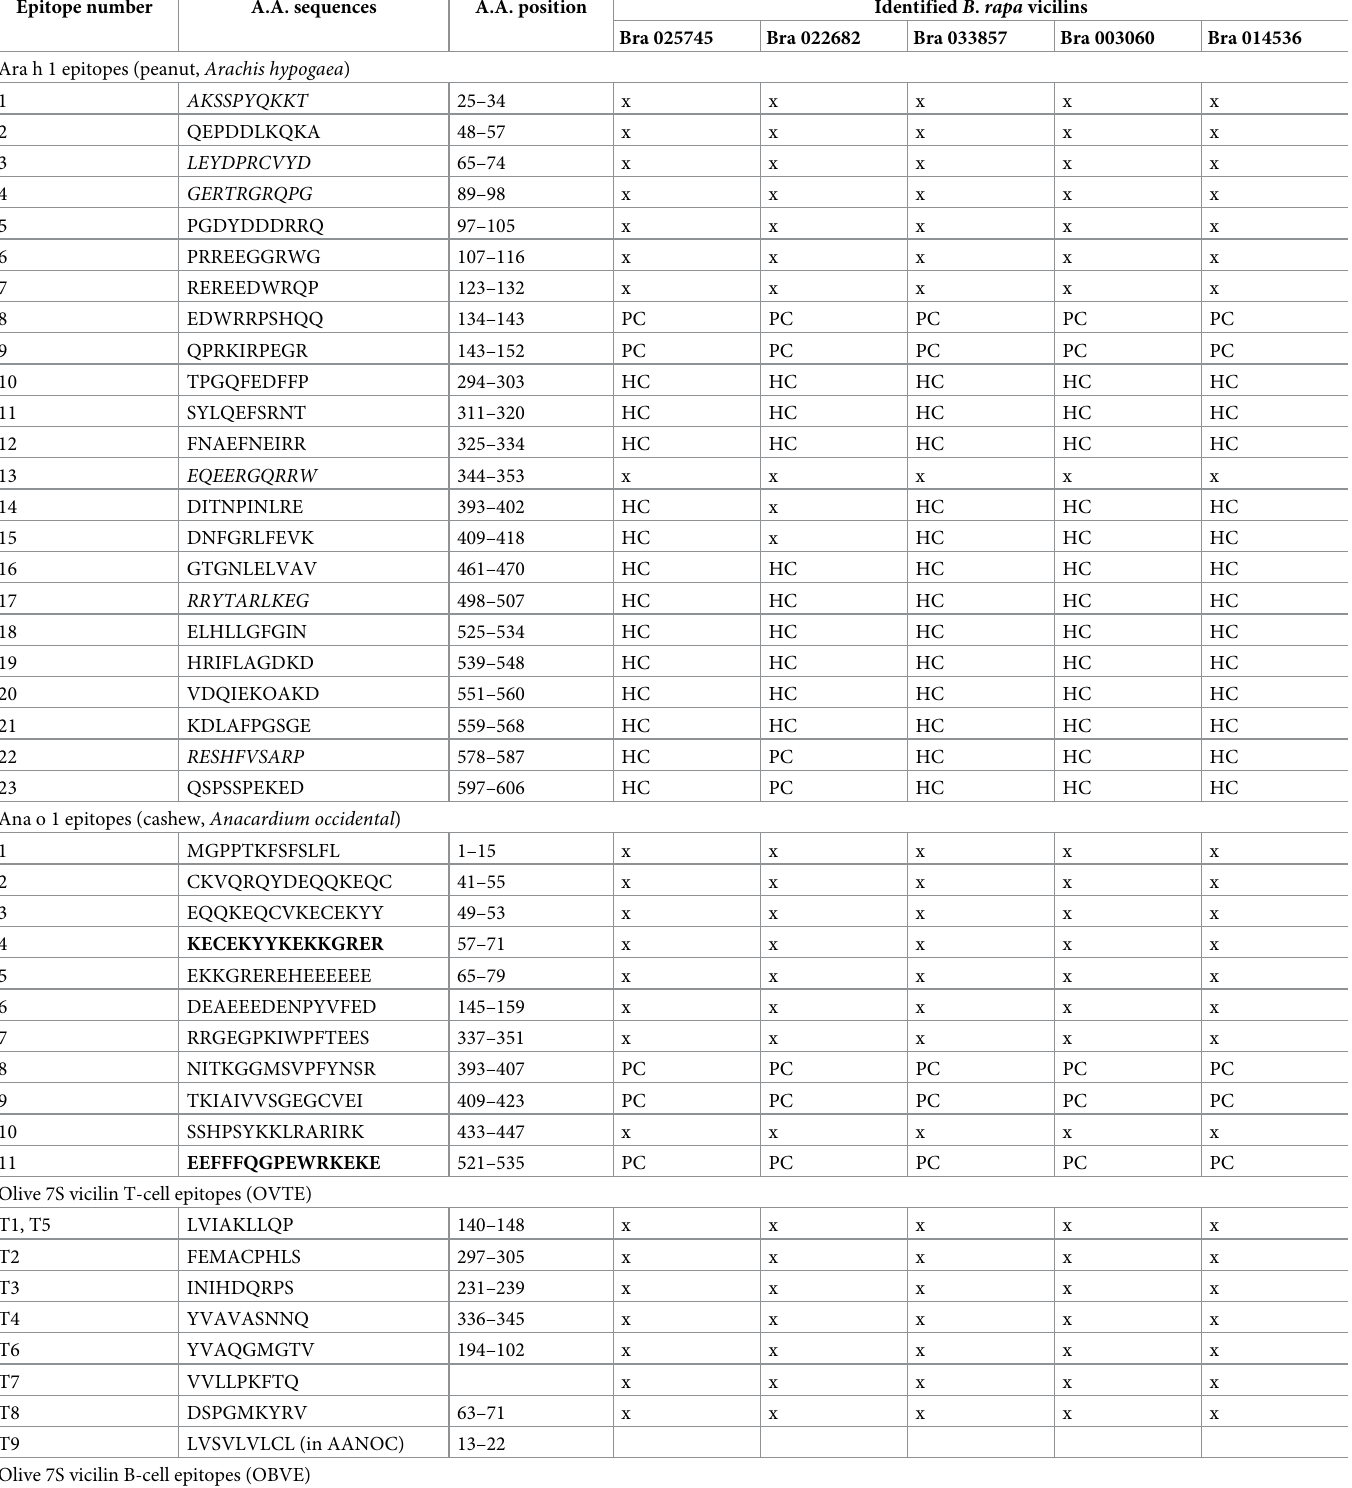
Table 1. Epitope mapping of Brassica rapa vicilin sequences with the twenty-three reported epitopes of the well-studied peanut vicilin allergen Ara h 1. Epitope